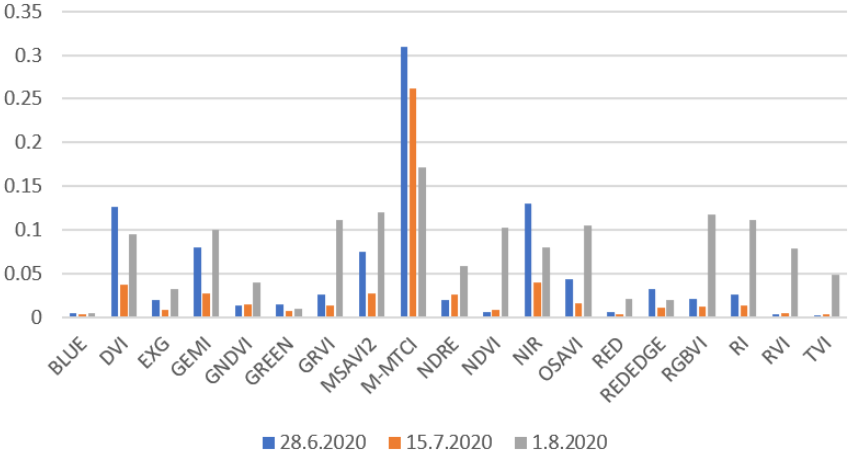
Figure 11. Standard deviations between the ten (15.7 and 1.8.2020) and nine (28.6.2020) measure- ments points for each spectral band/vegetation index. These values were calculated from 16:00 measurements. Zadoks values were 69 (28.6), 83 (15.7), and 86 (1.8). VIN vegetation index standard deviation values were not included in this image because they were so large and made it difficult to read other values. VIN standard deviation values for 16:00 measurements were 2.41 (28 June 2020),